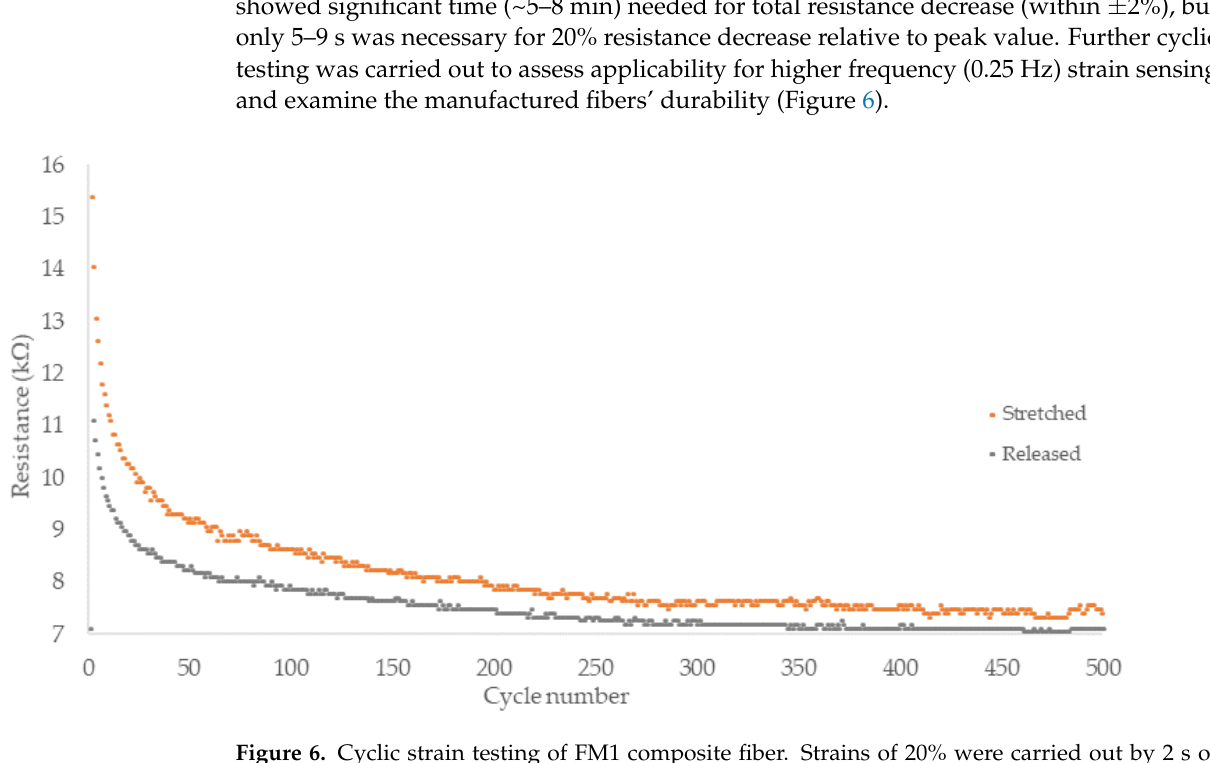
Figure 5. Cyclic strain testing of FM1 composite fiber. Strains of 10% were separated by 8 min of rest time to observe repeatability and dynamics of resistivity drop at unloaded state.